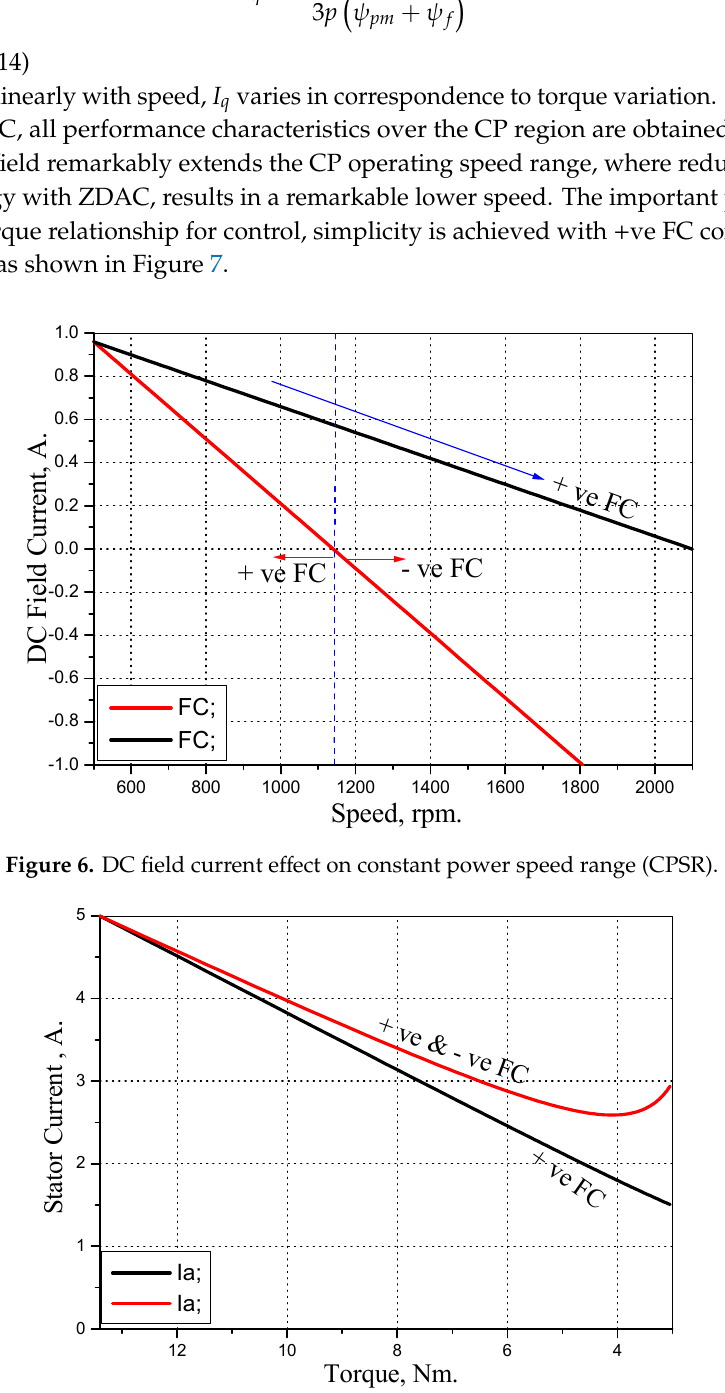
Figure 7. Stator current versus torque at reduced positive and reversed field current (FC).